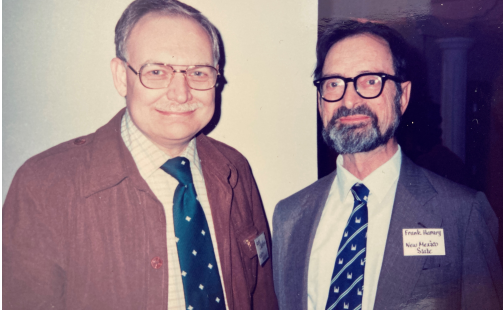
Figure 6: Gary Chartrand and Frank